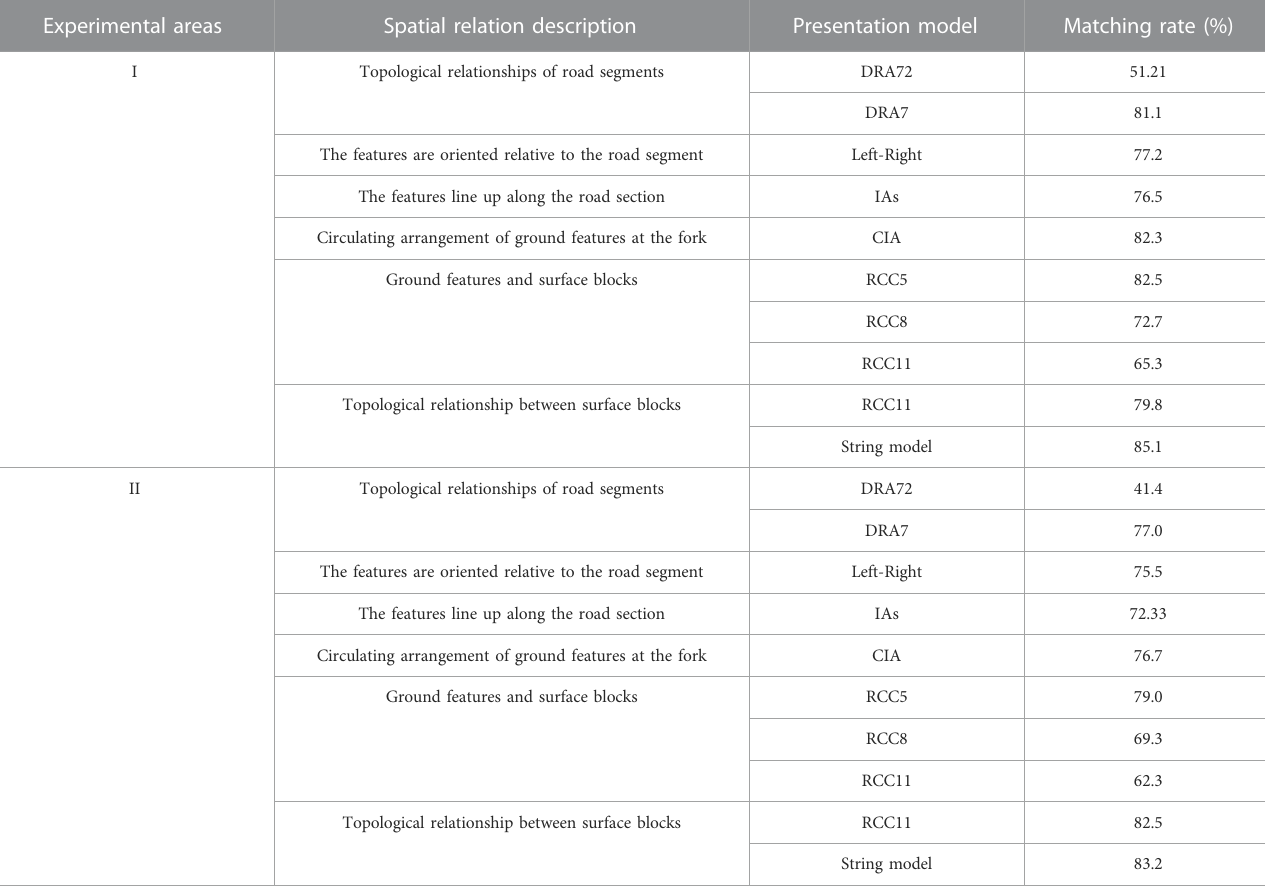
TABLE 4 Matching results and statistical calculation table based on different spatial relations. Experimental areas Spatial relation